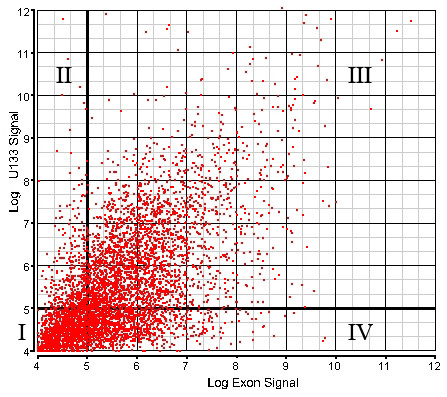
Pairwise comparison of signals from the Exon and U133 Plus 2 Arrays. Each dot represents the log2 (signal + 16) values for the same transcript cluster from the Exon Array (x-axis) and the U133 Plus 2 Array (y-axis) for breast tissues. Bold lines at signal value 5 divide the plot into quadrants I-IV for reference.